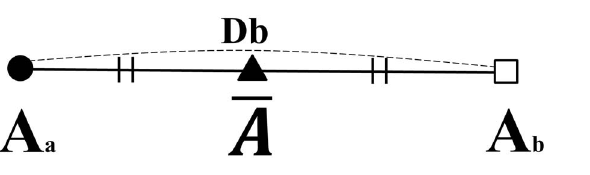
Figure 7. DX: Distance from X-axis to an averaged landmark. ( A ) The rotated arrow around X axis represents pitch